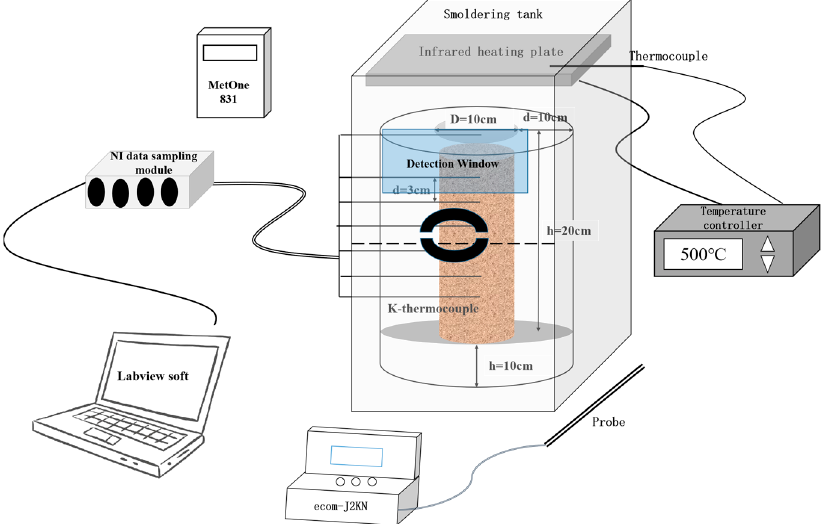
Figure 3. Schematic diagram of the experimental installation.